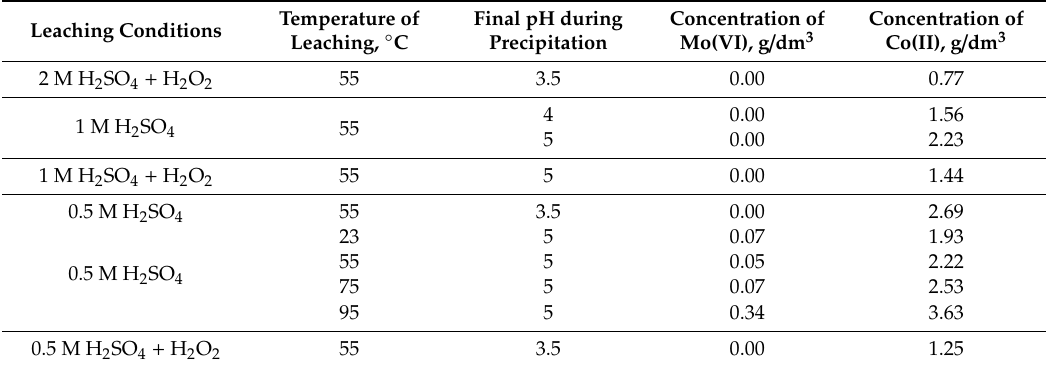
Co(II) and Mo(VI) concentrations in the stripping phase (after the forth step of leaching-precipitation-extraction-stripping process) for various conditions of the first step—leaching.